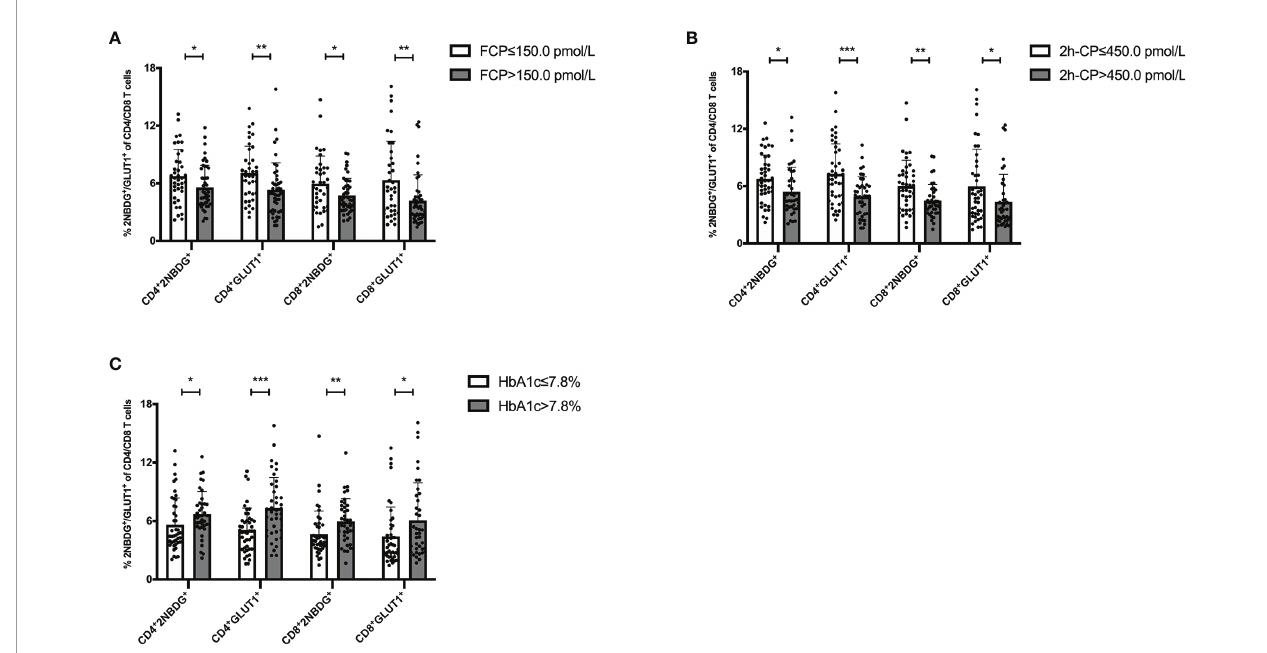
FIGURE 2 | The status of glucose uptake in T cells is related to clinical features of T1D. Patients with FCP>150.0 pmol/L (A) 2h-CP >450.0 pmol/L (B) and HbA1c ≤ 7.0%/53.0 mmol/mol (C) had lower glucose uptake in T cells. The bar and error bar = mean and SD. FCP, Fasting C-peptide; 2h-CP, 2 hours postprandial C-peptide;